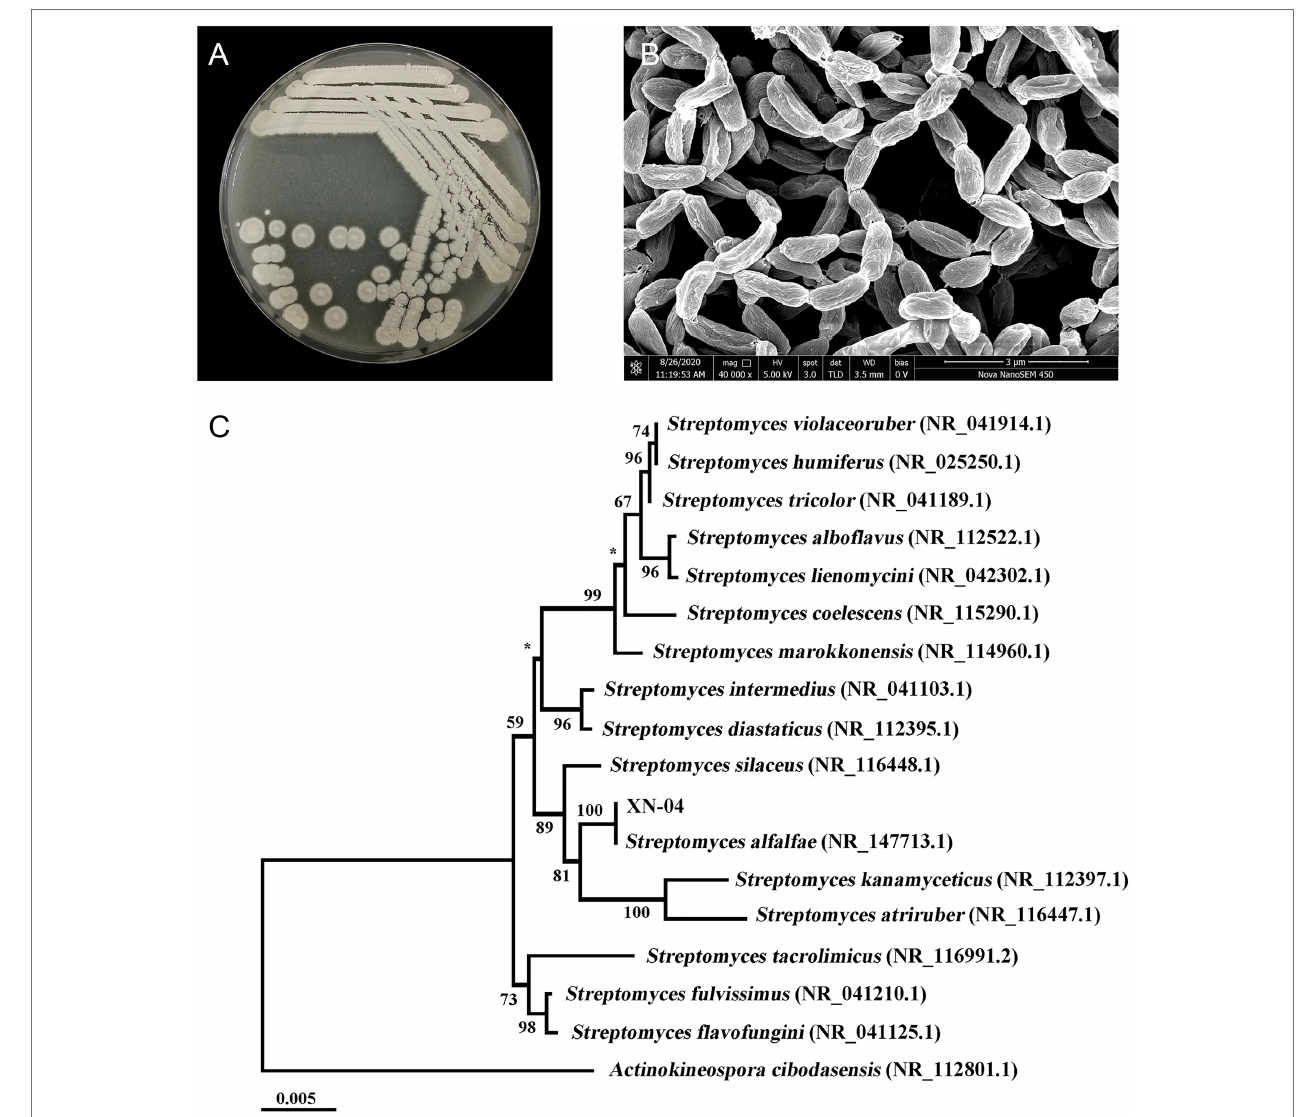
FIGURE 3 | Identification of XN-04. (A) Colony morphology of XN-04 on MS medium after 14 days of incubation at 28 ° C. (B) SEM of XN-04 grown on MS medium for 14 days at 28 ° C. (C) A phylogenetic tree based on 16S rRNA gene sequences showing the phylogenetic position of XN-04 and the type strains of related taxa. The branches are scaled in terms of the expected number of substitutions per site (see bar). Support values from neighbor-joining bootstrapping are shown above the branches if >50%. Bar, 0.005 expected substitutions per